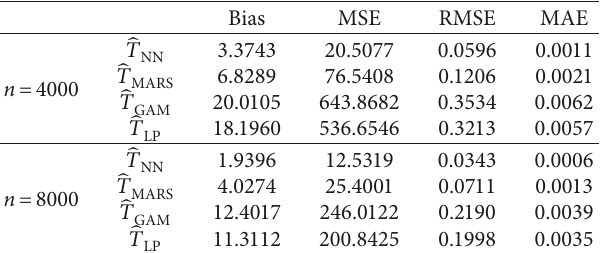
Table 2: UBIAS, UMSE, URMSE, and UMAE for a two-dimen- sional quadratic model.